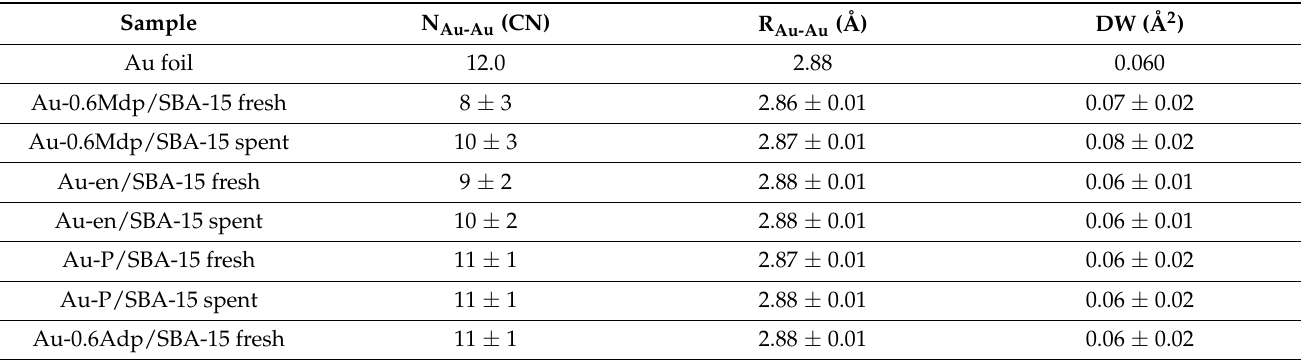
Figure 6. Wide-angle XRD of the fresh samples.